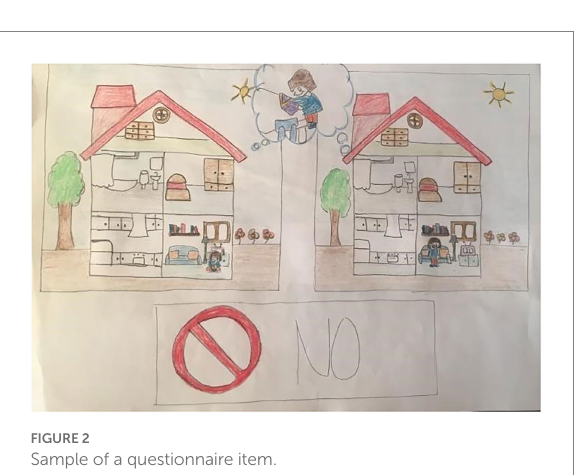
FIGURE 2 Sample of a questionnaire item.